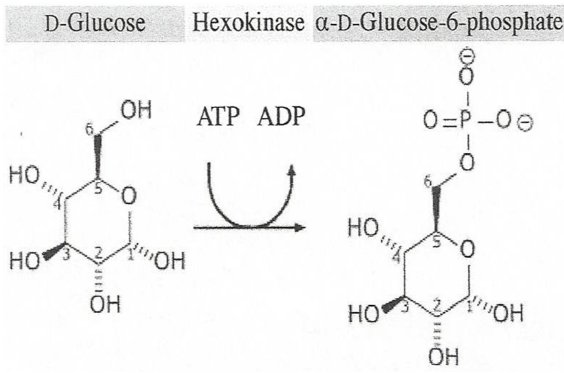
Figure 4. Schematic view of the phosphorylation of glucose (Wikipedia) [27].